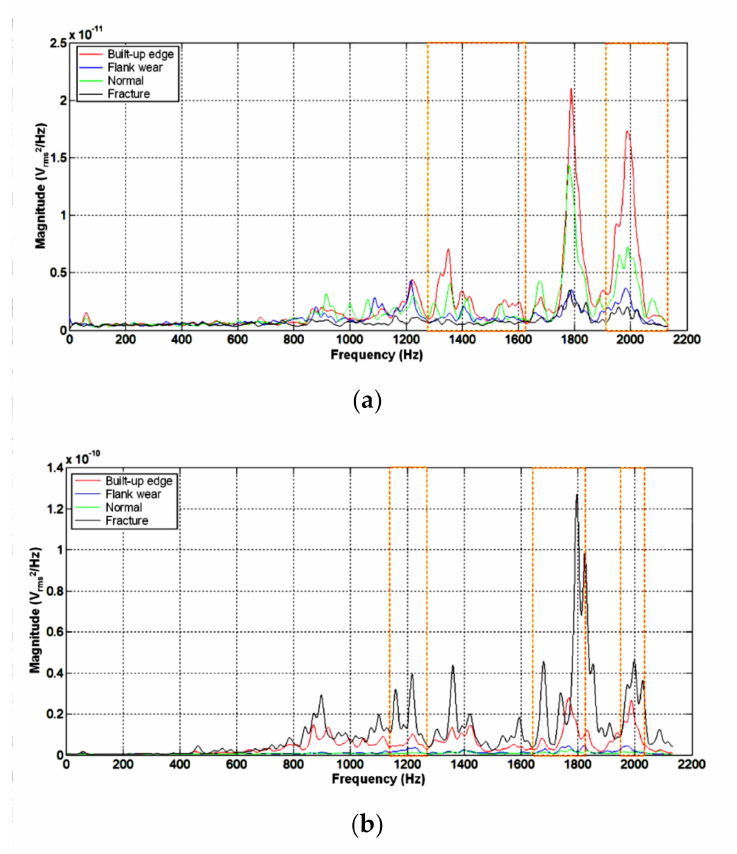
Figure 4. Resultant PSD distribution diagrams of di ff erent machining conditions. ( a ) Machining condition 1; ( b ) Machining condition